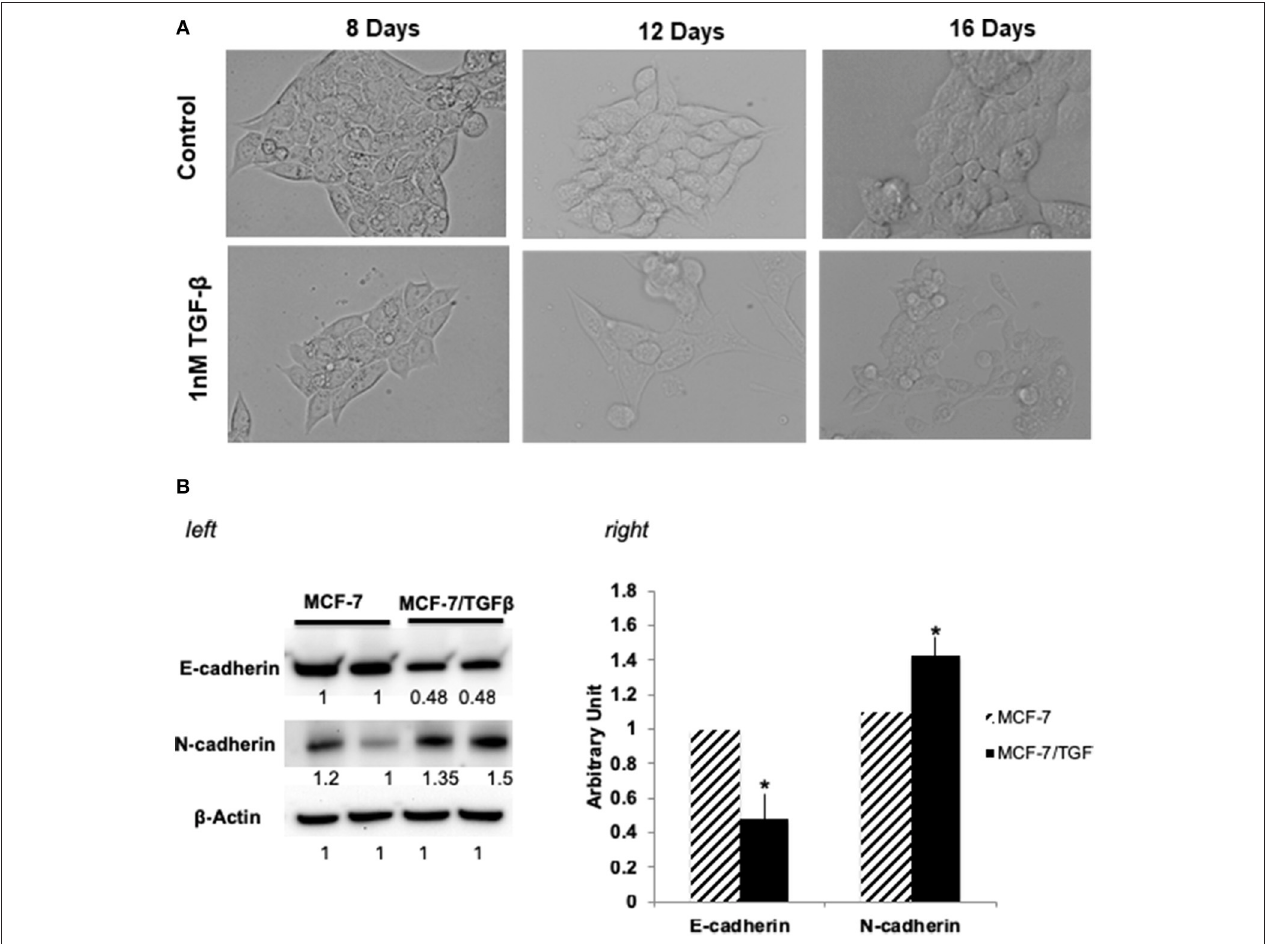
FIGURE 1 | (A) Morphological change in MCF-7 cells during TGF β –induced EMT. Images of cells treated long term (16 days) with TGF β showing spindle-shaped morphology as compared with control. Images were acquired by phase contrast microscopy using a 20 × objective. (B) (left) Immunoblot analysis of expression of EMT-related proteins. Protein expression levels of E-cadherin in TGF β -treated MCF-7 cells were markedly decreased, whereas expression levels of N-cadherin and vimentin (mesenchymal markers) were dramatically increased. Numbers below each panel indicate the relative integrated density of the protein band in that lane. (right) Quantification analysis of the Western blot data showing the change in EMT markers (E-cadherin and N- cadherin) in MCF-7/TGF β cells vs. MCF-7 breast cancer cells. The relative quantification was normalized against β -actin using image J image analysis software. All data represent the mean ± S.D of three different experiments. * p < 0.05, student- t